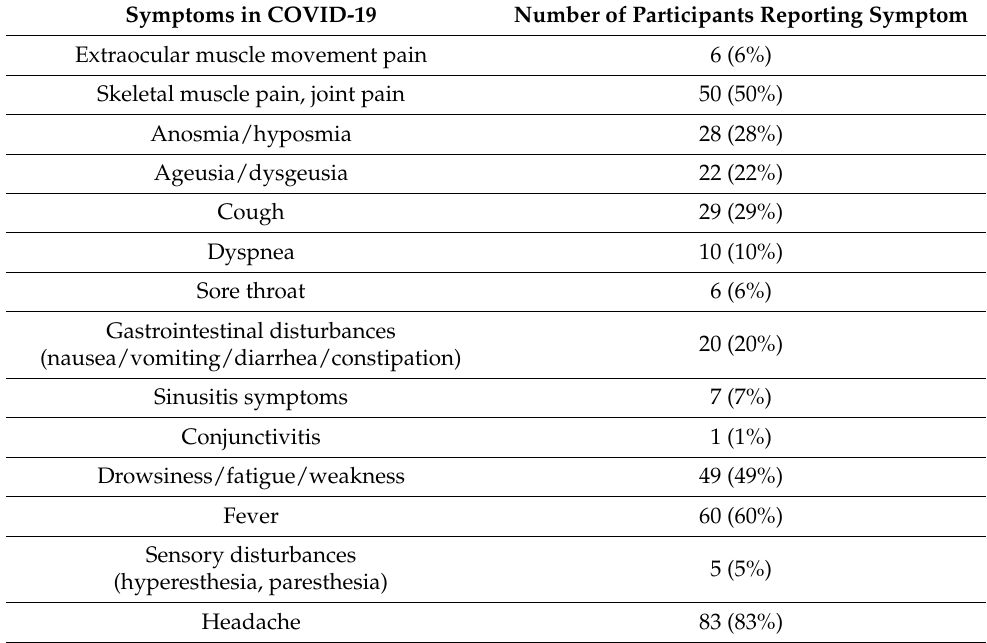
Table 1. Most frequent symptoms reported by our study patients.